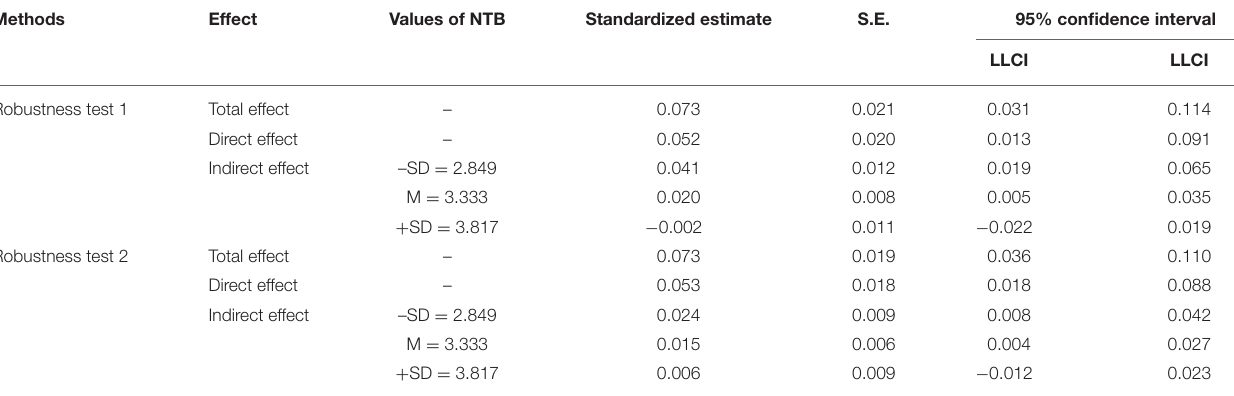
TABLE 4 | The result of robustness test (bootstrapping times = 5,000, N =